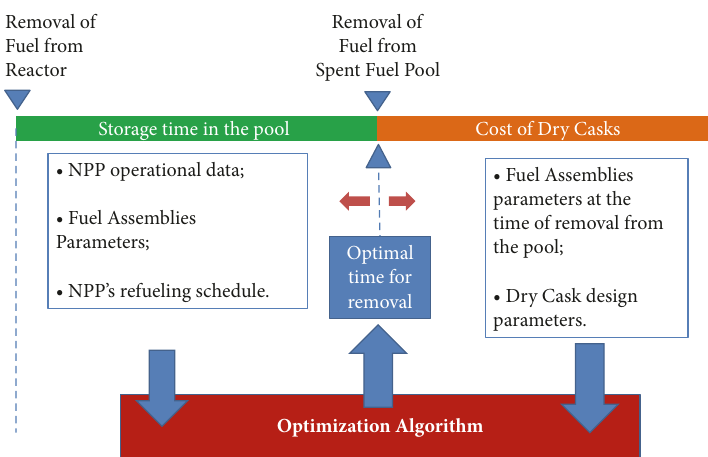
Figure 1: Overview of the spent fuel management optimization methodology.